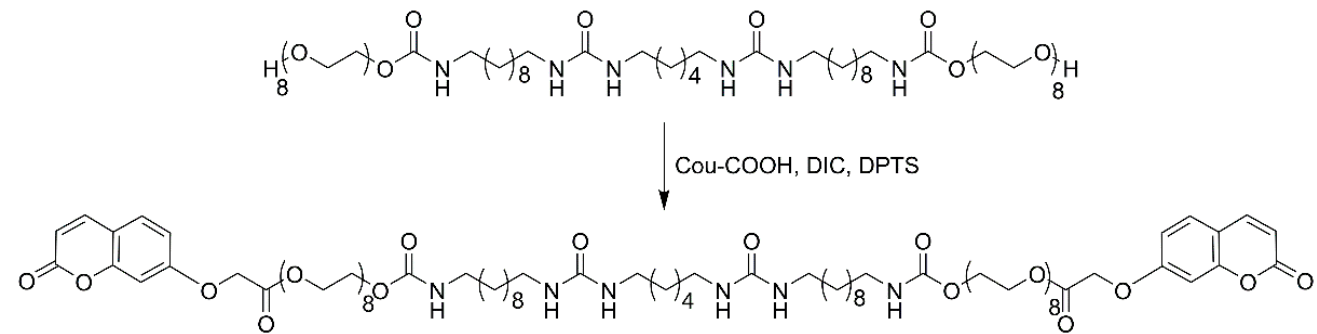
Figure 1. The model reaction of Cou-OEG300 under UV light. ( a ) Optical image of 10 mg/mL turbid Cou-OEG300 aqueous solution and UV-induced dimerization of coumarin units in micelles. ( b ) Re- versibility study of UV-induced dimerization monitored by 1 H NMR.2.2. Synthesis of a Coumarin- Functionalized